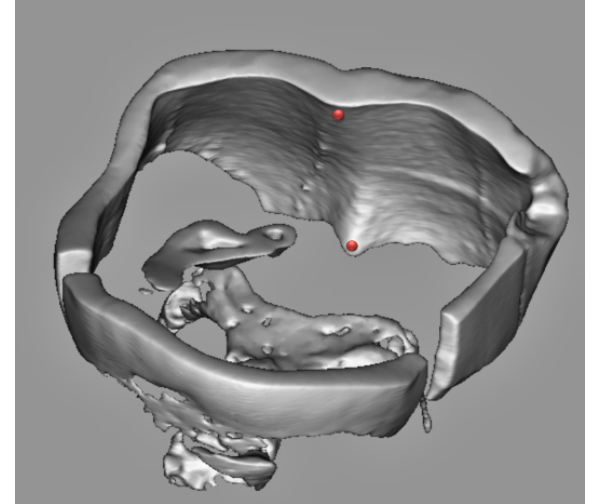
Figure 3. Reconstruction of enamel and pulpal chamber of sample lt 8 with initial landmarks set.